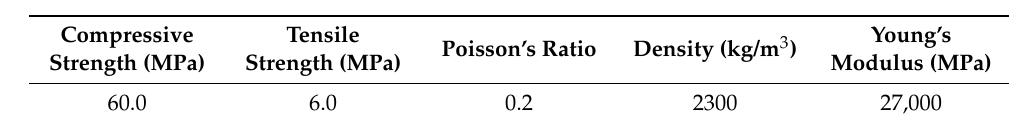
Table 6. Material parameter of